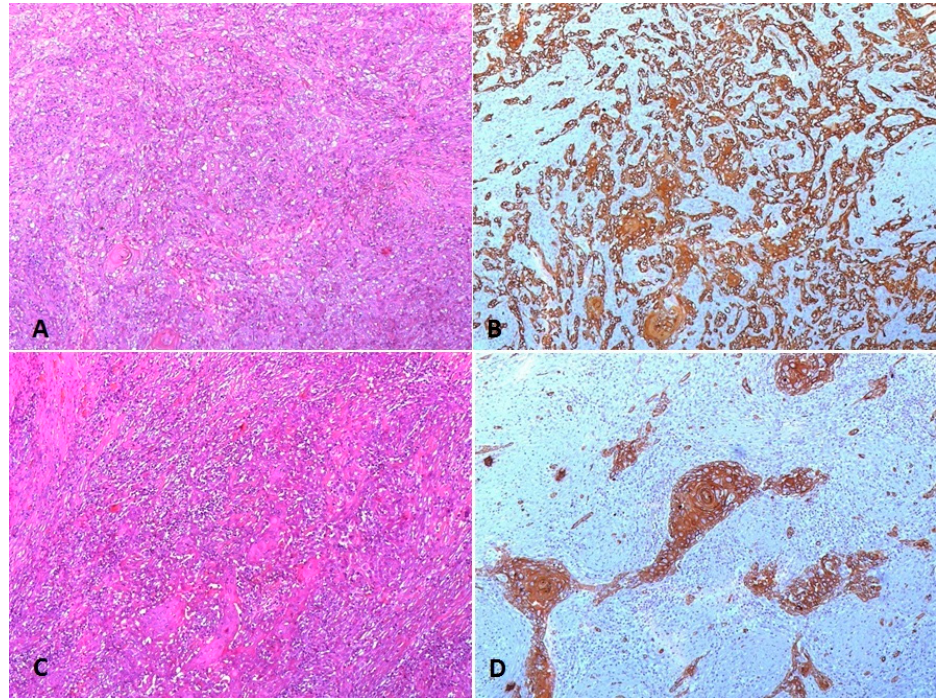
Figure 2. ( A ) Thyroid neoplastic cells of the anaplastic epithelial type with focal squamoid nests